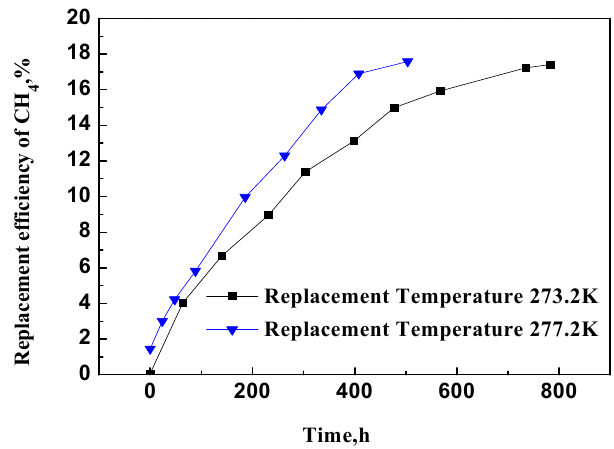
Figure 5. Replacement efficiency of CH at different replacement